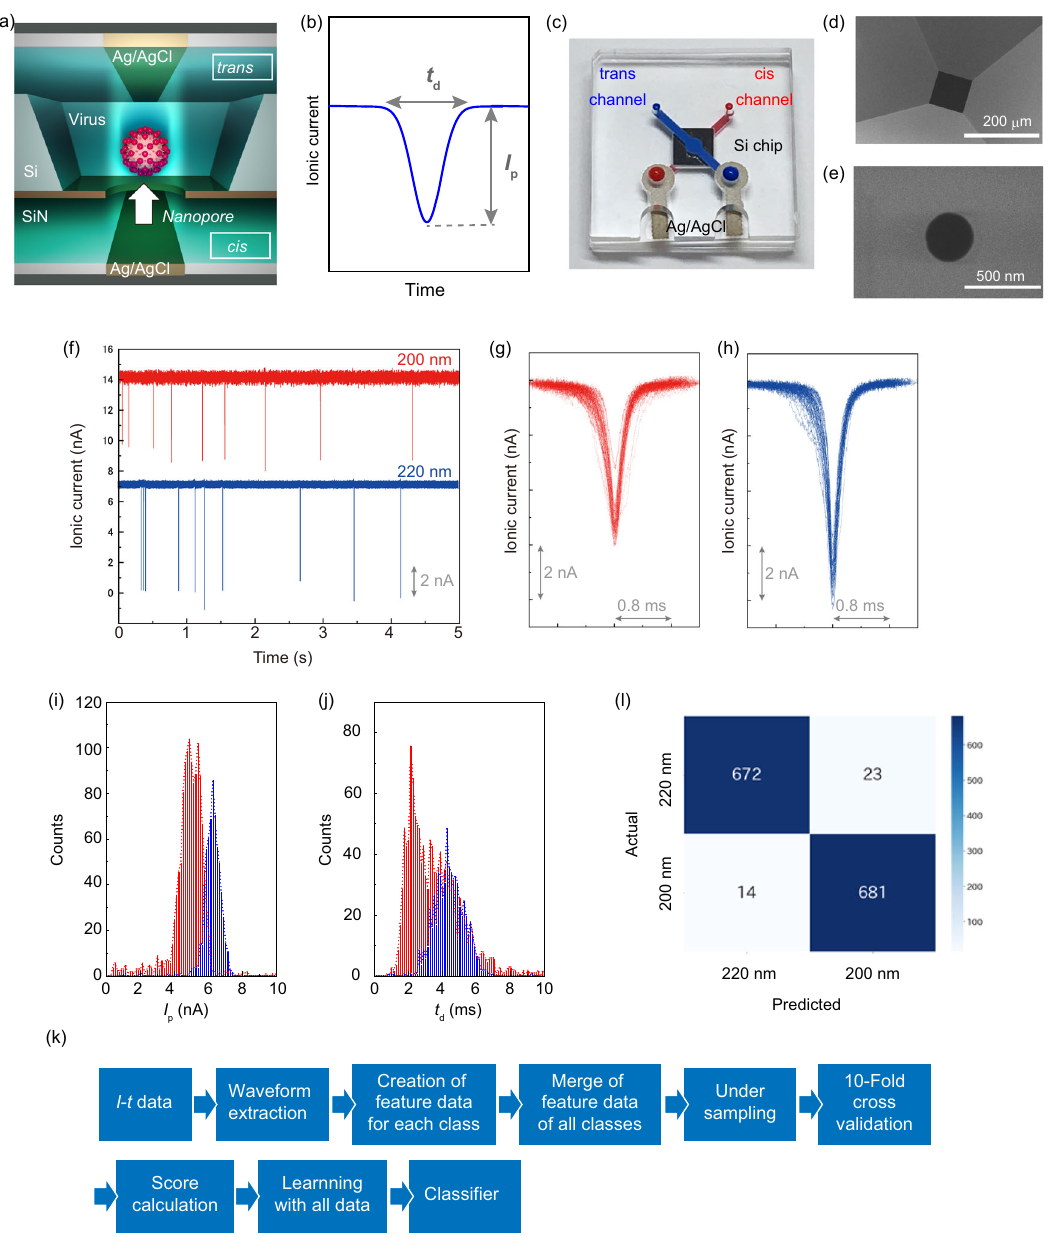
Fig. 1 Basic characteristics of AI-nanopore platform. a Nanopore structure fabricated in silicon nitride (SiN) membrane on a silicon (Si) substrate. A specimen and a buffer are placed in the cis and trans channels. Silver – silver chloride (Ag/AgCl) electrodes are placed on both sides of the substrate. b Ionic current fl ows when voltage is applied. I p and t d show the peak current and duration of the current of an ionic current waveform, respectively. c An optical photographic image of the nanopore module. Red and blue are cis and trans channels, respectively. The black central part is a silicon chip with nanopores. d , e Scanning electron microscope image of the nanopore entrance and the nanopore with a diameter of 300 nm seen from the trans side. The black region in the center of the image is a hollow SiN thin fi lm. Six times experiments were repeated independently for the observations. f Ionic current – time traces of nanoparticles with 200 and 220 nm diameter. g , h Ionic current – time pro fi les, which show an overlap of 100 waveforms each, obtained by nanoparticle measurements. The color code corresponds to f . i , and j , Histograms of I p and t d of nanoparticles. The color code corresponds to f . k , Machine learning algorithm used to identify the nanoparticles and cultured viruses. l Confusion matrix of nanoparticles obtained by machine learning. The numbers in the matrix represent the number of waveforms obtained by the measurements. The color bar indicates that the darker the blue, the greater the number of pulses. The number of the color bar indicated the number of waveforms. Source data of f – j and l are provided as a Source Data fi